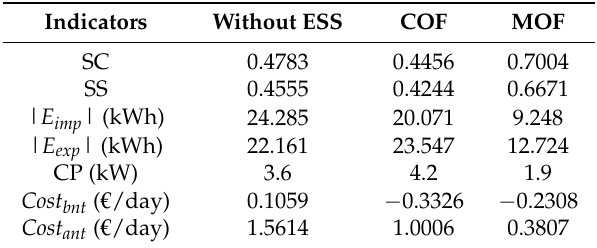
Figure 10. Generation, demand and modified demand hourly power curves of the whole microgrid, during scheduled 24 h, in the new case study: ( a ) COF; ( b ) MOF. Table 7. SC and SS rates, energy import and export and economic indicators for the whole coordinated microgrid, in the new case study.